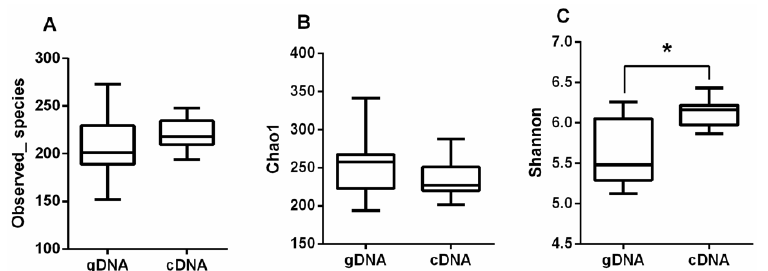
Figure 2. Alpha diversity of rumen ureolytic bacteria of gDNA and cDNA. ( A ) Total observed species, ( B ) Chao1, and ( C ) Shannon index. Boxplots indicate the first and third quartiles with the median value indicated as a horizontal line the whickers extend to 1.5 times the inter quartile range. * p < 0.05.